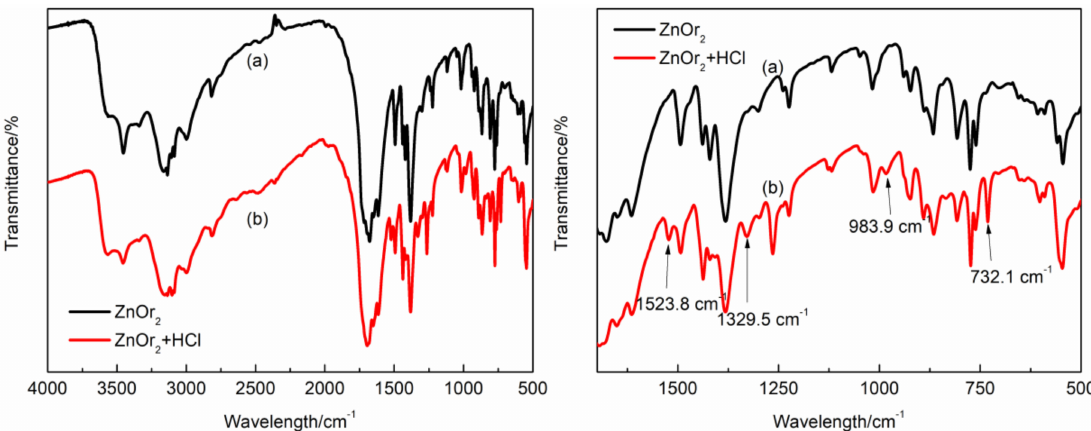
Figure 6. The FTIR spectra of ZnOr 2 before ( a ) and after ( b ) treatment by HCl at 180 ◦ C for 1 h in the ranges of 4000–500 cm − 1 ( left ) and 1700–500 cm − 1 ( right